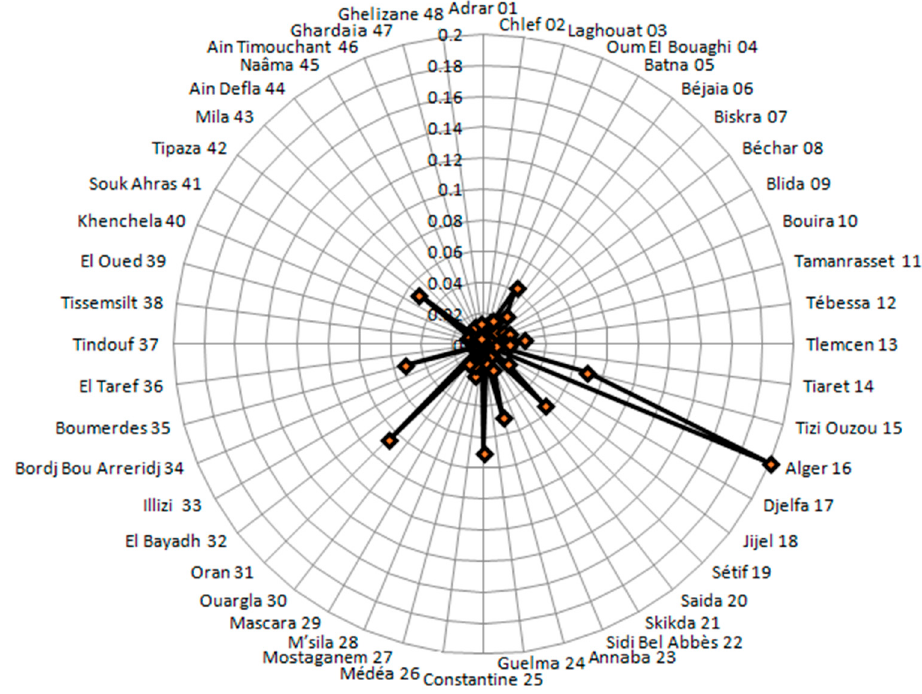
Figure 10. Radar plot of Morbidity rates in the provinces (48 provinces) by COVID-19 between 1 January 2021 and 15 August 2021.